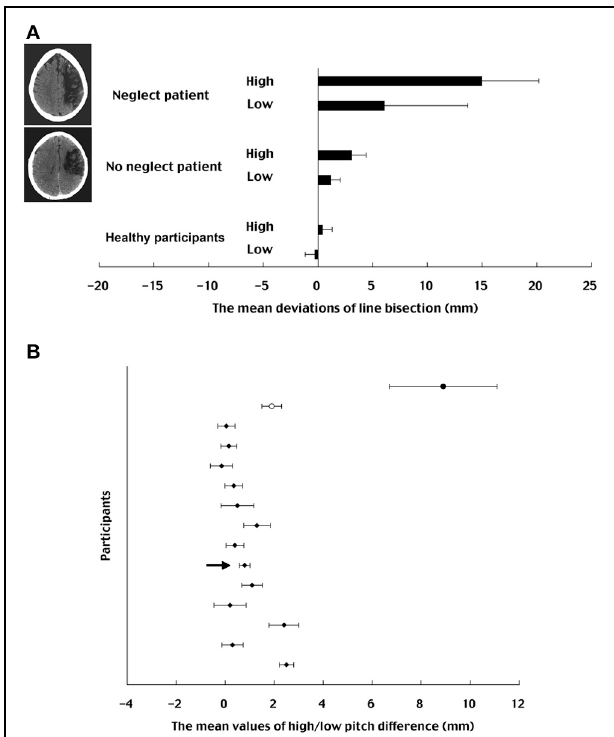
FIGURE 2 | (A) The mean deviations of line bisection for auditory pitch in each patient. MRI scans of the neglect and no-neglect patients are presented together. The mean deviations for each pitch in healthy participants of Experiment 1 (horizontal orientation with alternative pitch presentation condition) were also imposed on the figure. Each bar indicates the range of one standard error. (B) The mean values of high/low pitch difference in each participant (filled circle: neglect patient; unfilled circle: no-neglect patient; filled diamond: normal healthy participants). Each bar indicates the standard deviation. The arrow indicates the data point of a selected healthy participant used for specific analyses specified in the